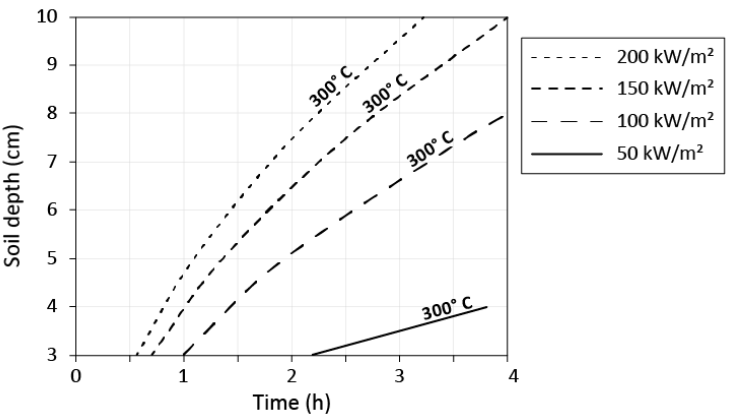
Figure 16. Assembly installed over a wooden deck without gypsum board. Relationship of time to failure of the deck (300 °C was reached under different thermal loads) and substrate thickness.